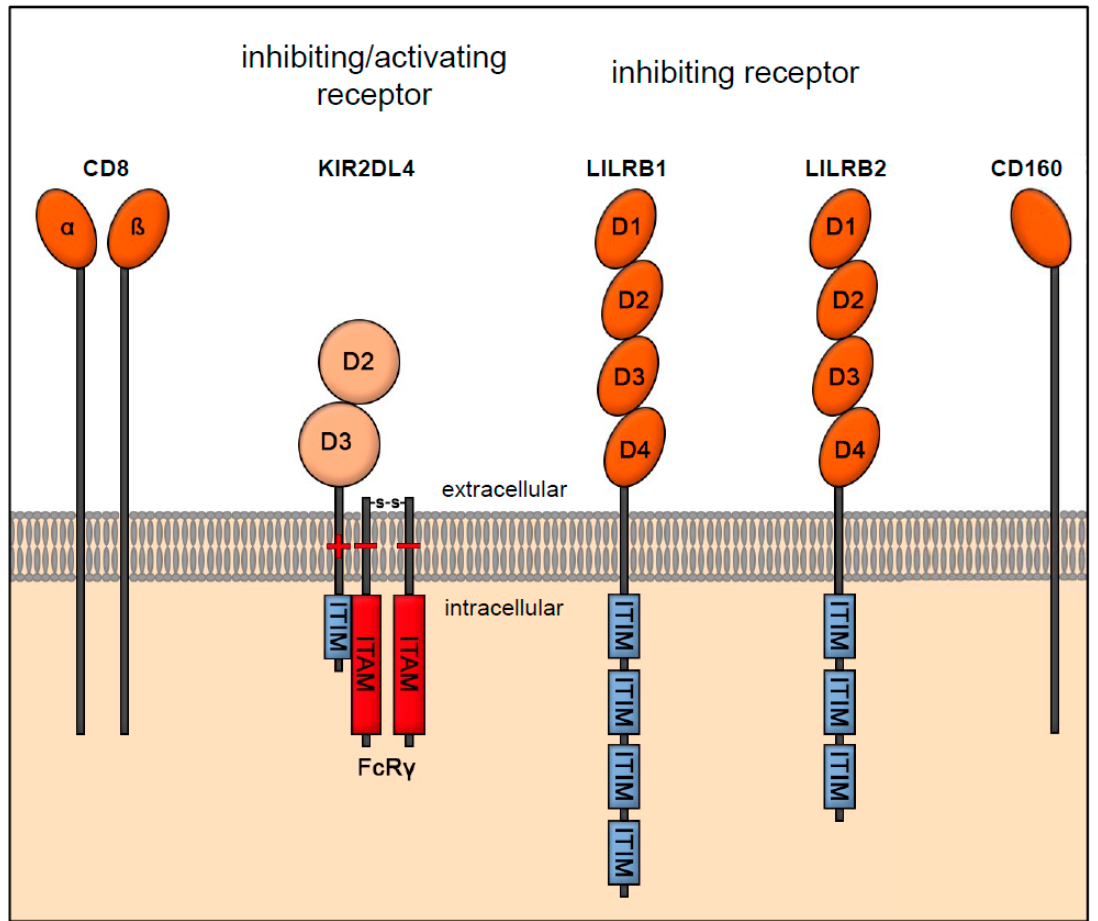
Figure 3. Receptor interaction of HLA-G with CD8, KIR2DL4, LILRB1, LILRB2 and CD160. CD8 is a marker for cytotoxic T-cells and consists of an extracellular alpha and beta domain [88]. The receptor KIR2DL4 belongs to the family of killer cell immunoglobulin-like receptors (KIRs), which are expressed on NK cells. The receptor contains two extracellular domains D0 and D1 and has only one immunoreceptor tyrosine-based inhibition motifs (ITIM). A charged arginine residue in its cytoplasmatic tail enables KIR2DL4 to form a complex with Fc fragment receptor γ (FcR γ ), which stimulates cytokine production in the NK cell [55]. The inhibitory leukocyte-immunoglobulin (Ig)-like receptors (LILR) LILRB1 (also known as Ig-like transcript 2; ILT2) and -B2 (also known as ILT4) are expressed on monocytes, dendritic cells (DCs), as well as on B-, T-, and NK cells and mediate an inhibitory signal via their ITIMs [36,39,74]. CD160 is a glycosylphosphatidylinositol-anchored receptor and does not contain an immunoreceptor tyrosine-based activating motif (ITAM) [89].